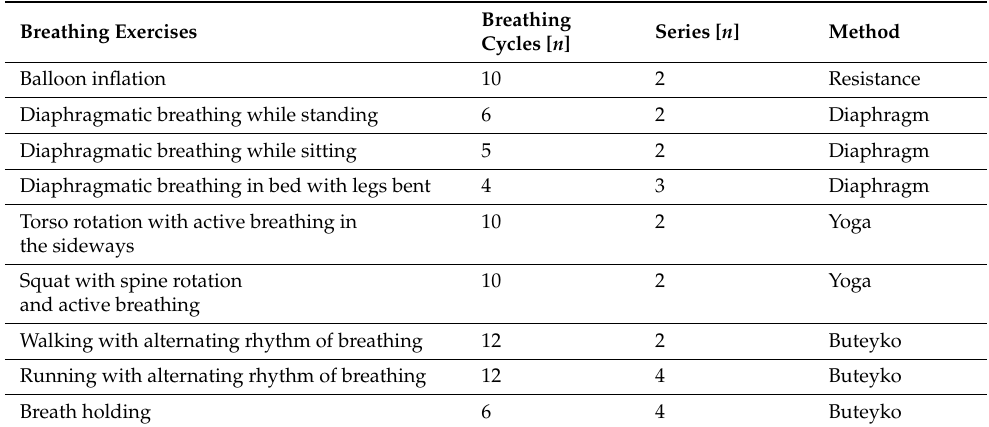
Table 2. Descriptions of breathing